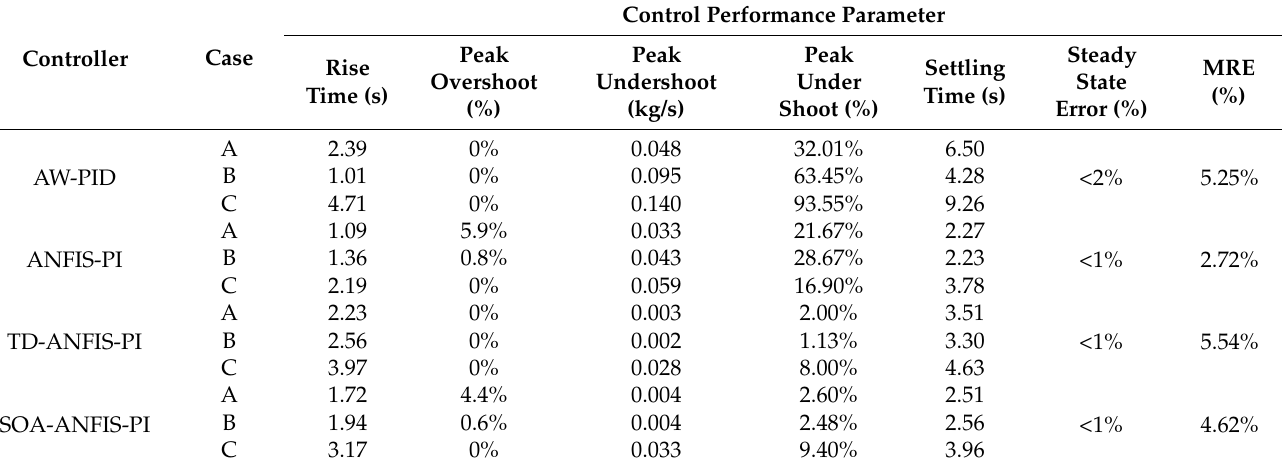
Table 3. Control performance for different